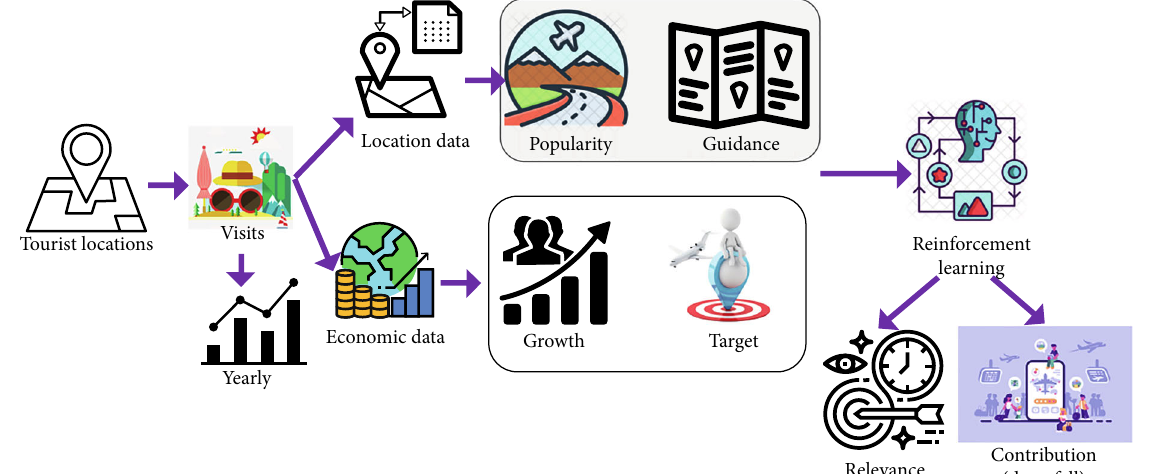
Figure 1: Proposed ORDAA